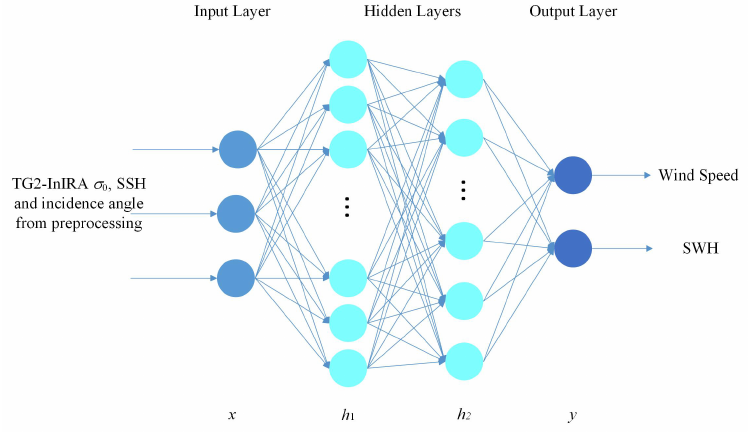
Figure 7. Structure of the four-layer MLP model with one input layer, one output layer and two hidden layers.